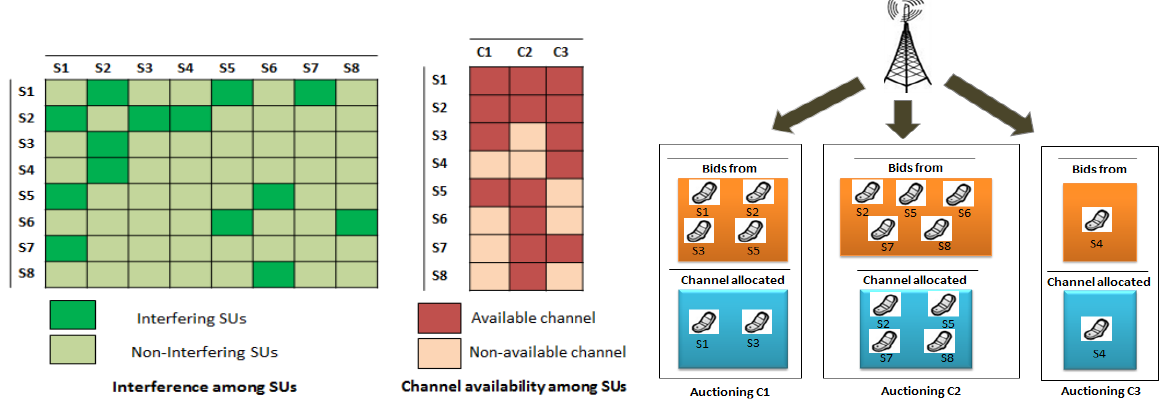
Figure 2. Diagrammatic representation of system